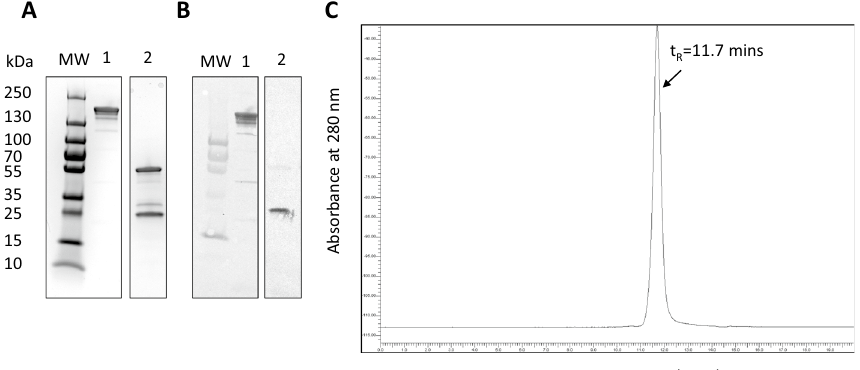
Fig. 1 A SDS-PAGE analysis of trastuzumab under non-reducing conditions (lane 1) or reducing conditions (DTT, lane 2) on a 4–20% Tris HCl gradient mini-gel. MW: broad range molecular weight standards. The gel was stained with Coomassie R-250 Brilliant Blue. B Corresponding Western blot under non-reducing (lane 1) or reducing (lane 2) conditions showing immunopositivity with goat anti-human Fab specific IgG-horseradish peroxidase (HRP) immunoconjugates. Bands were detected by reaction with diamidobenzidine/0.03% H 2 O 2 . C SE-HPLC analysis of trastuzumab on a BioSep SEC-s4000 column (Phenomenex, Torrance, CA, USA) eluted with 100 mM NaH 2 PO 4 buffer, pH 7.0 at a flow rate of 0.8 mL/min with UV detection at 280